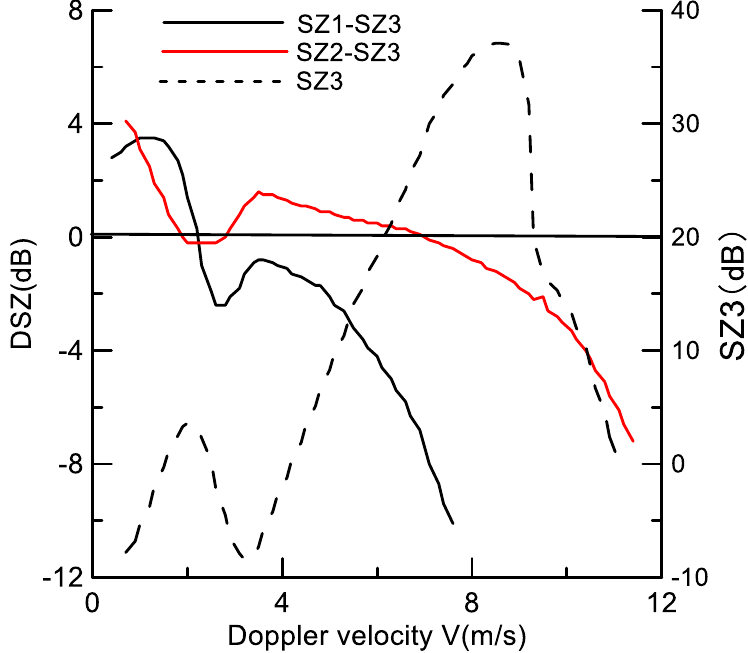
Figure 5. Variations in the averaged bias of the reflectivity spectra with Doppler velocity between SZ1 and SZ3 and between SZ2 and SZ3. The averaged SZ3 is also